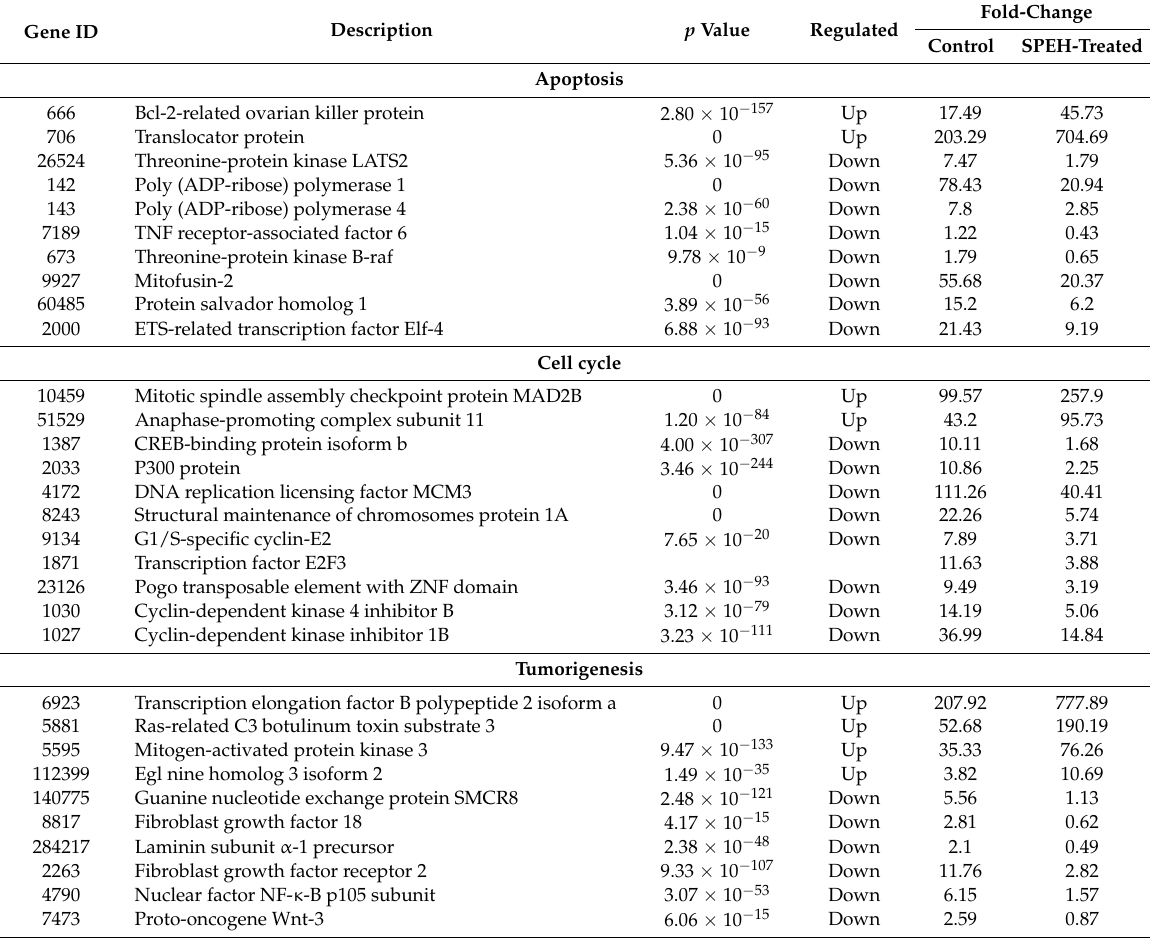
Table 1. Changes in the transcriptional expression of key genes related to cell apoptosis, cell cycle and tumorigenesis in response to SPPH treatment. Fold-changes are indicated for each gene significantly up- or down-regulated ( p < 0.05, fold-change > 2) in SPEH-treatment group compared with the